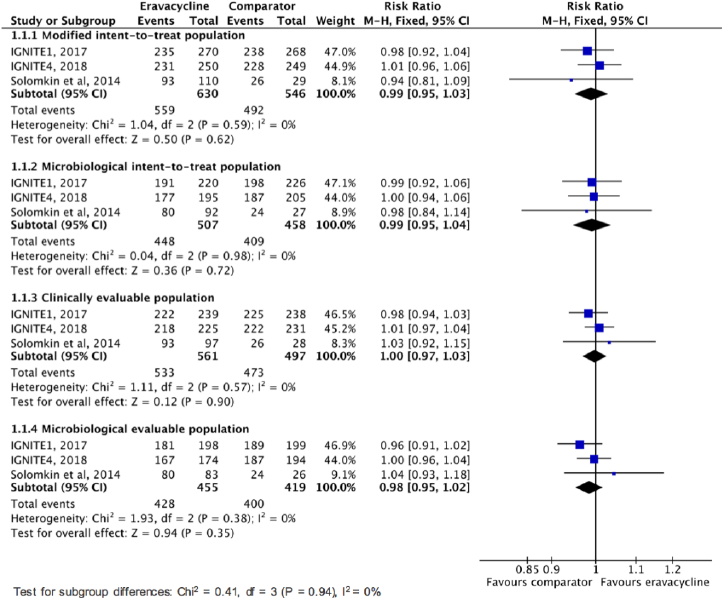
Figure 2. Overall clinical cure rates for eravacycline and comparators in the treatment of complicated intra-abdominal infections. J. Clin. Med. 2019 , 8 , x FOR PEER REVIEW